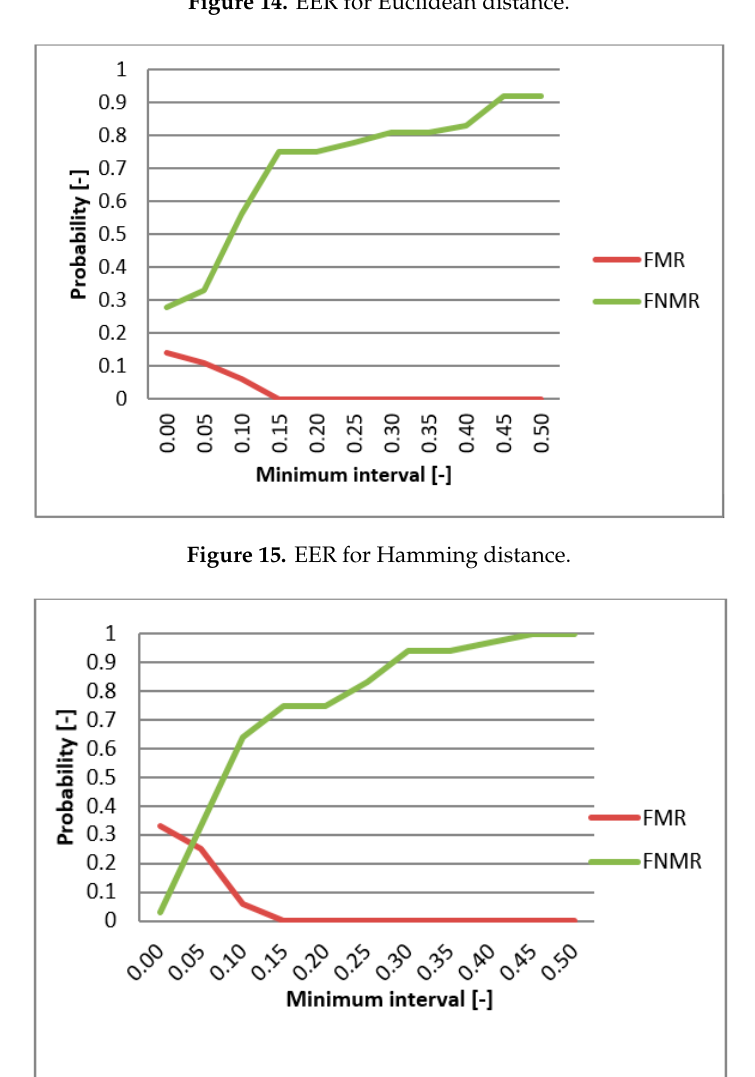
Figure 16. EER for Figure 16 . EER for HV. Figure 16 . EER for HV. Figure 16 . EER for HV.